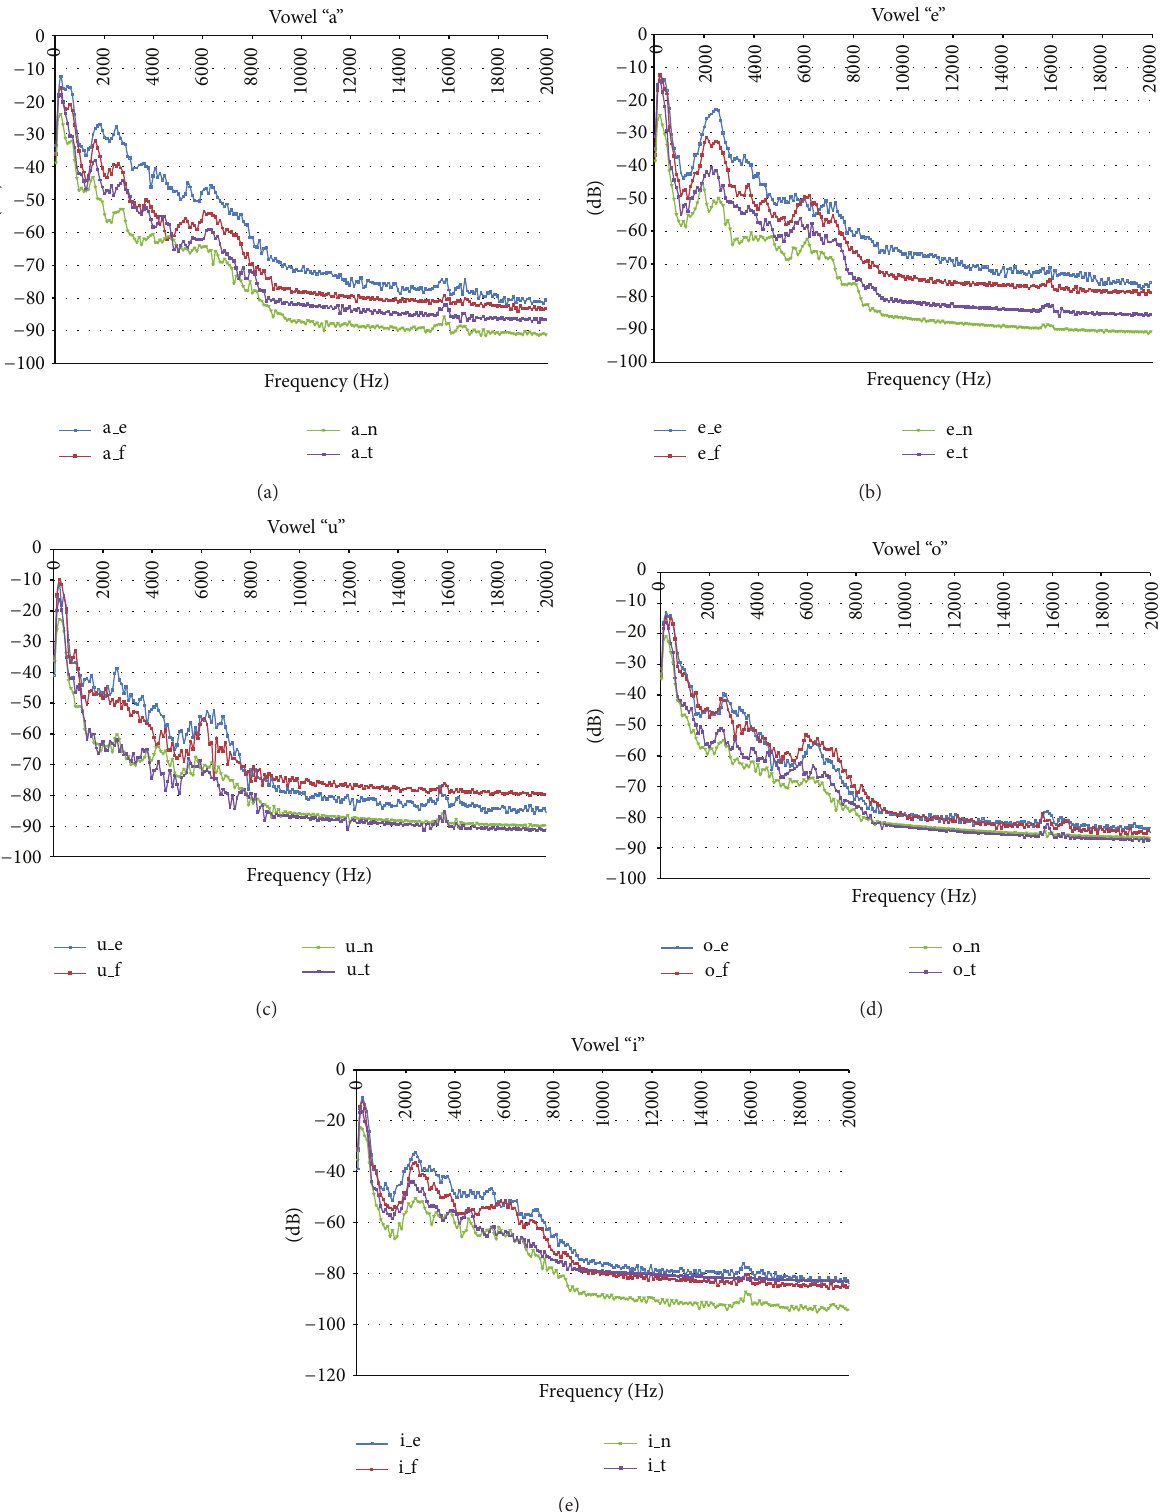
Figure 2: Average spectrum for all emotion-specific vowels across all male speakers. Description of identifiers: e = anger, f = happiness, n = neutral, and t =